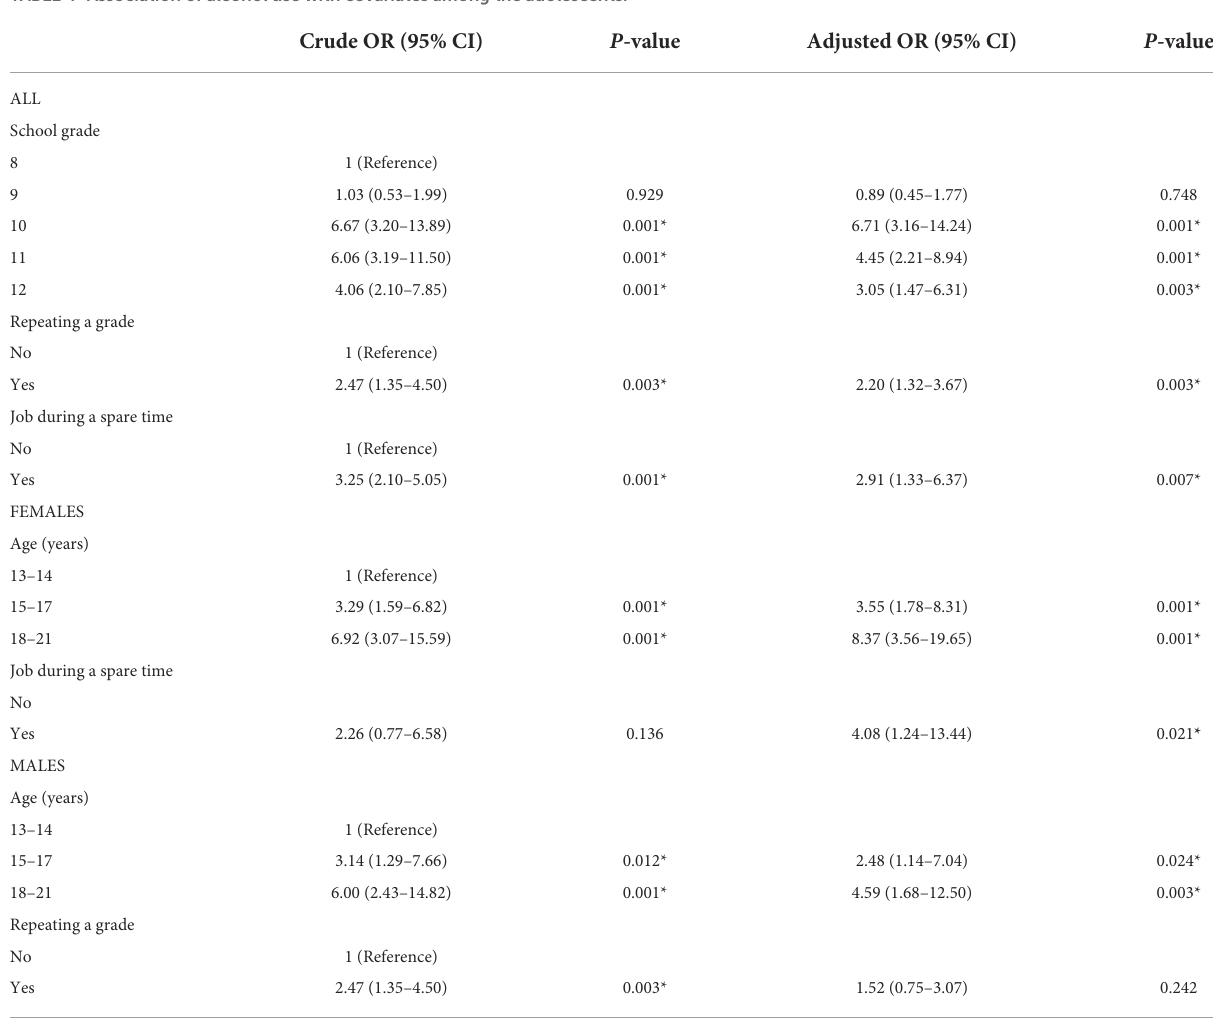
TABLE 4 Association of alcohol use with covariates among the adolescents. Crude OR (95% CI) P -value Adjusted OR (95% CI) P